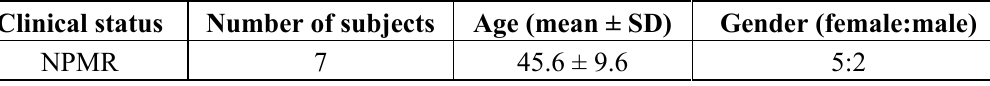
Table 1. Data for subjects included in the